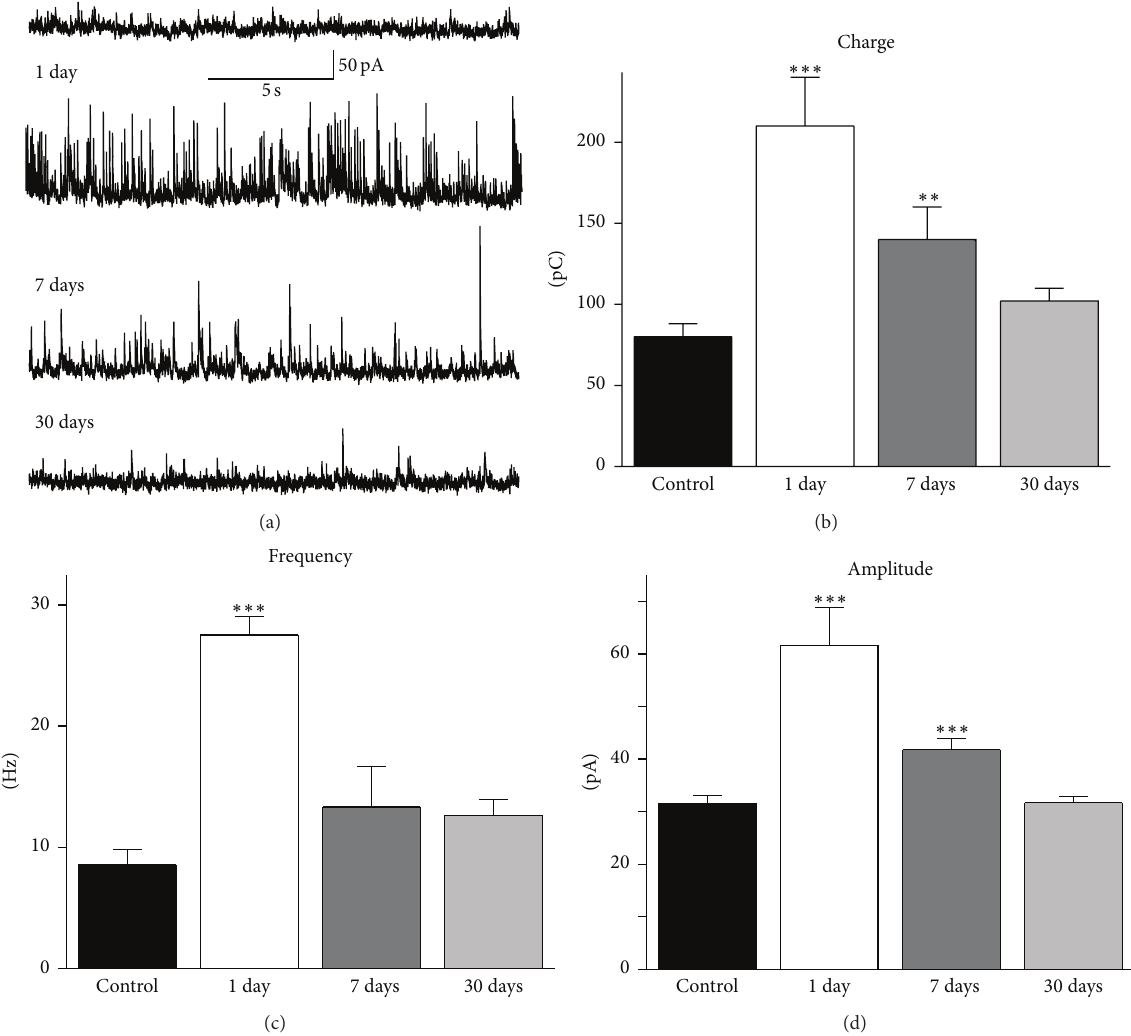
Figure 3: Effects of repeated isoflurane exposures on basal GABAergic synaptic activity in the BLA. Whole-cell recordings of spontaneous IPSCs (sIPSCs) were obtained from principal neurons, at a holding potential of +30 mV. (a) Representative traces of sIPSCs recorded from a control rat (top trace) and from rats who received repeated exposures to isoflurane; recordings were obtained at 1 day, 1 week, and 1 month after the last of the three exposures. (b) Group data showing that the total charge carried by the recorded currents was increased at 1 day and 1 week after the last of the three exposures but returned to levels that did not differ significantly from the control, 1 month after the exposures. (c) Group data of the frequency of sIPSCs, which was significantly increased at 1 day after repeated exposures. (d) Group data of the amplitude of sIPSCs, which was significantly higher than that in the control group, at 1 day and 7 days after repeated exposures. ∗∗∗ 𝑃 < 0.001 and ∗∗ 𝑃 < 0.01 ; 𝑛 = 13 for the control group; 𝑛 = 17 for the 1-day group, 𝑛 = 9 for the 1-week group; and 𝑛 = 16 for the 1-month